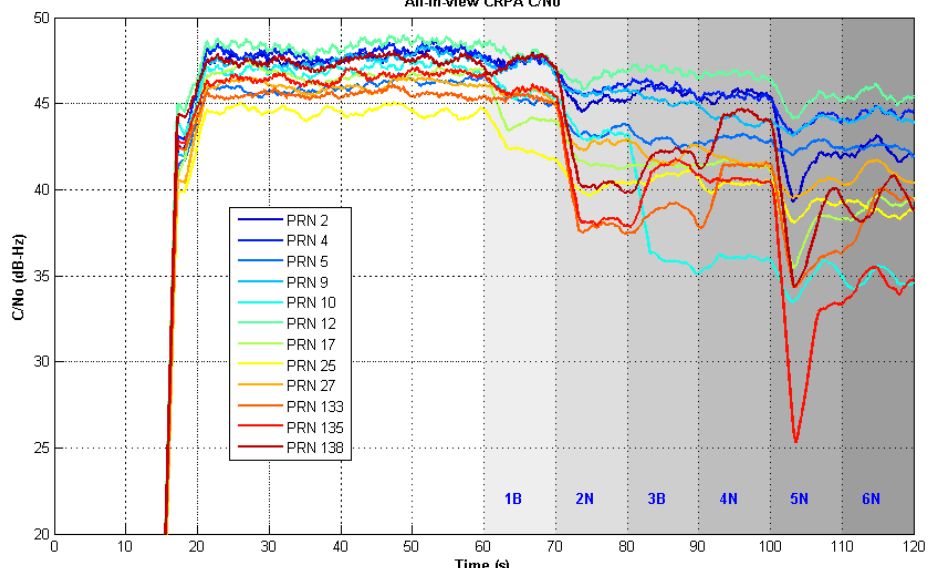
under two broadband and four narrowband 0